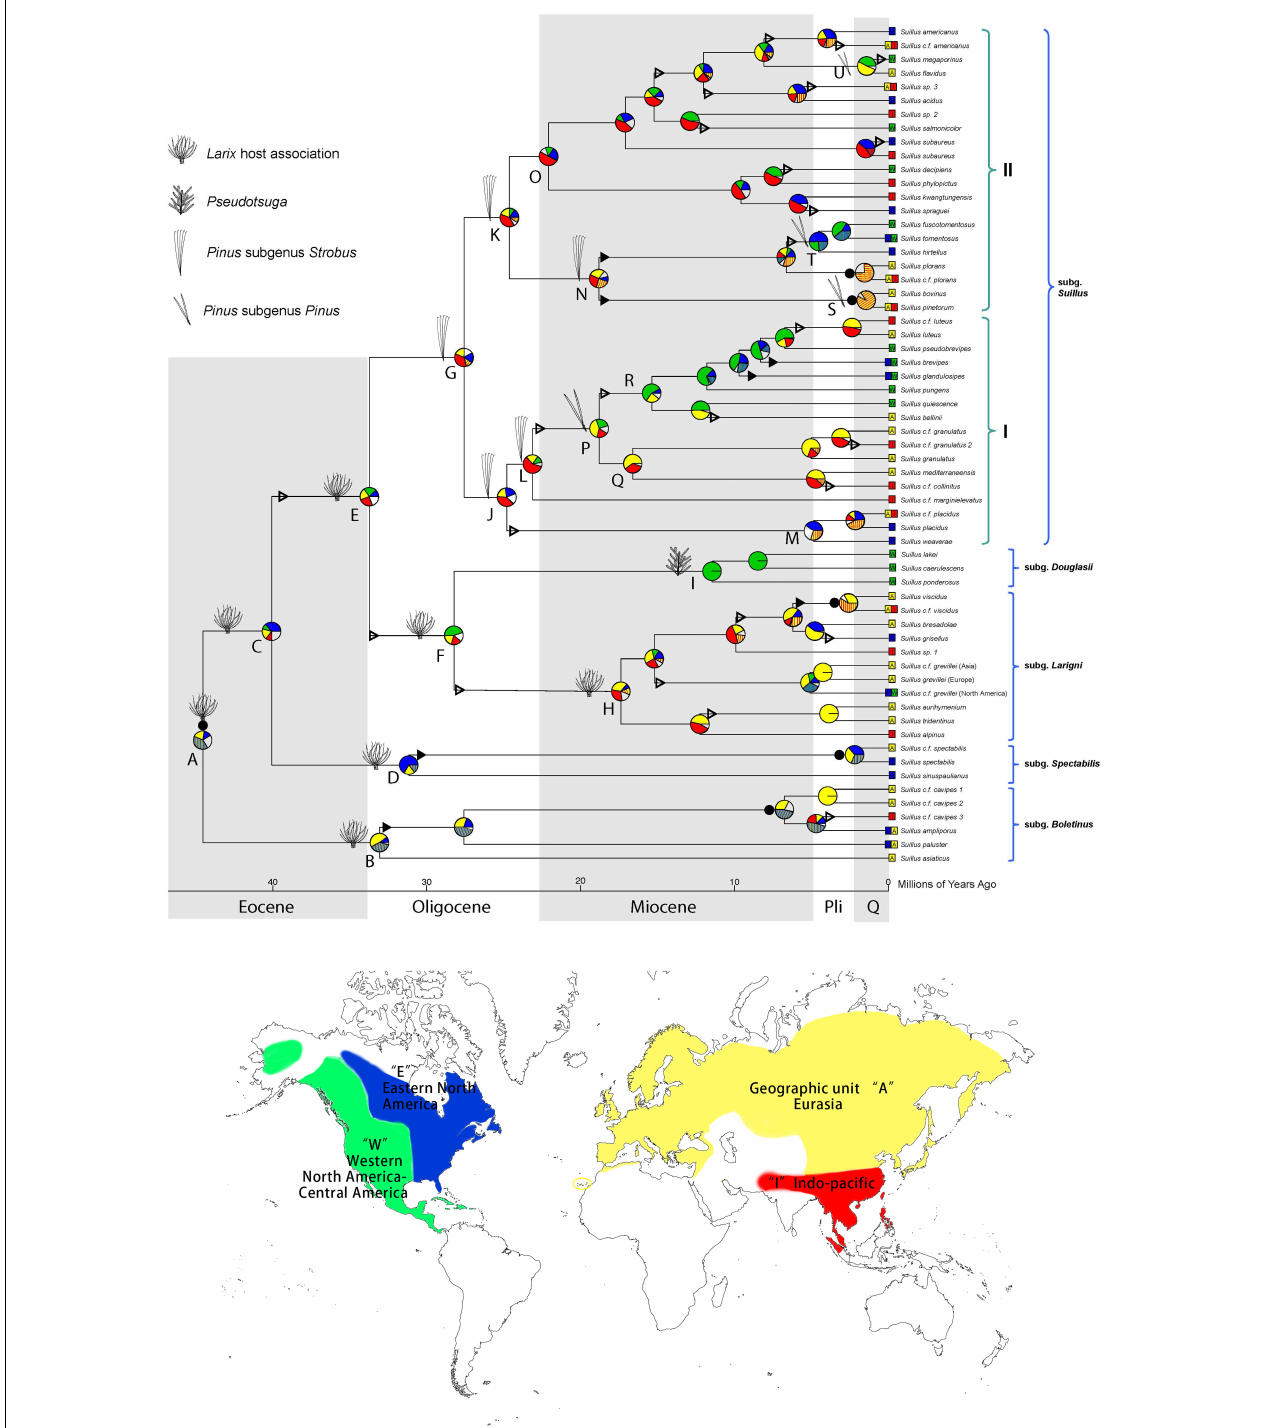
FIGURE 1 | Historical biogeography of Suillus estimated by DEC + J model in BioGeoBEARS. Pie diagrams at each node denote geographical units or combination of units occupied by ancestral taxa. Geographic units are represented by different colors. Combined units are shown by hatching colors or by lettering. Width of pie wedges refers to the probability of that geographic unit or combination of units. White wedges indicate the sum of the units (or combined units) with individual probabilities < 15%. Triangles on branches denote “jump” dispersal events (founder effect cladogenesis), solid triangles indicate range expansion dispersal events (anagenesis), and solid circles by pie diagrams represent vicariant speciation events. Ancestral host associations were annotated at the nodes. Letters by key nodes are discussed in the text. Current geographic ranges of terminal taxa are indicated by colored boxes and lettering. Parentheses indicate the subgenera and section as